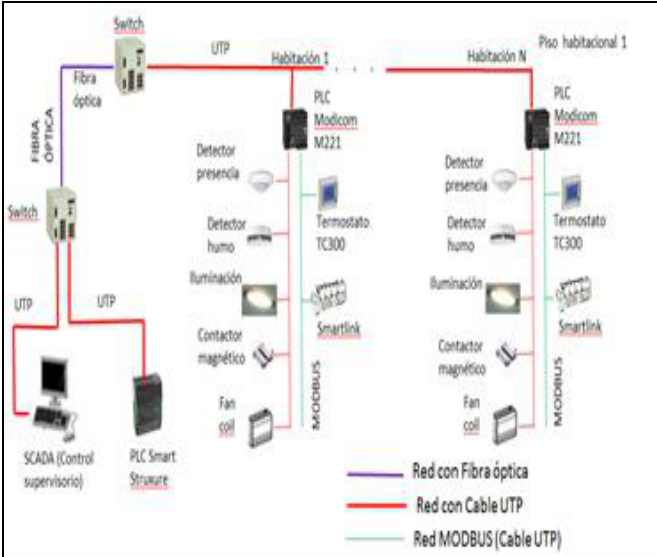
Figura 4: Esquema de comunicación horizontal. Fuente: Los autores,